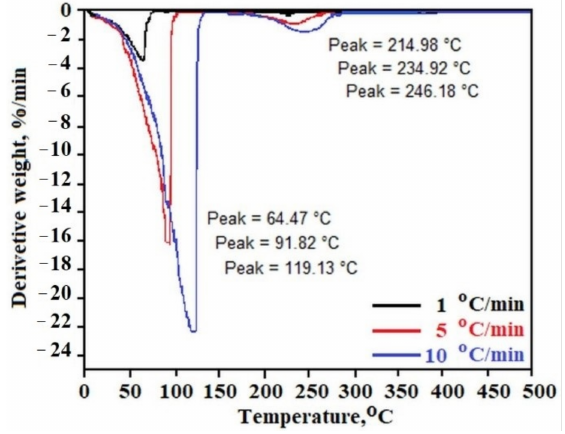
Figure 2. Temperature dependence of the derivative of weight loss of C 12 ALA-AuNP measured in a function of heating rates by TGA.